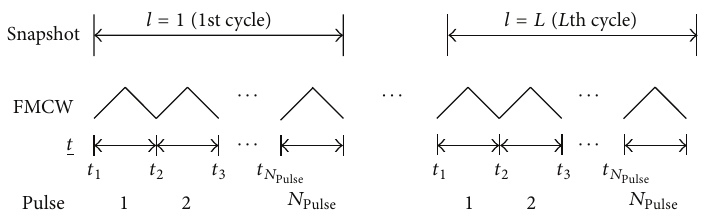
Figure 3: Structure of the cycles in data